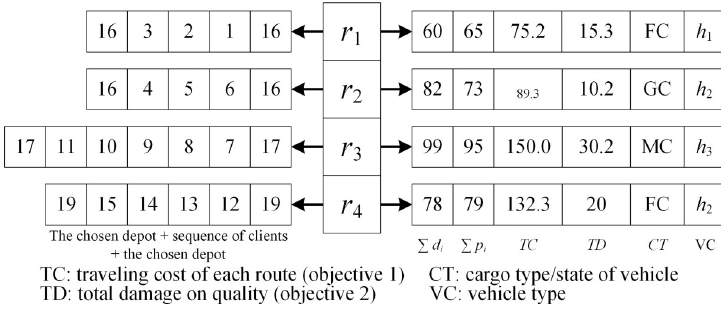
Fig 2. A simple solution